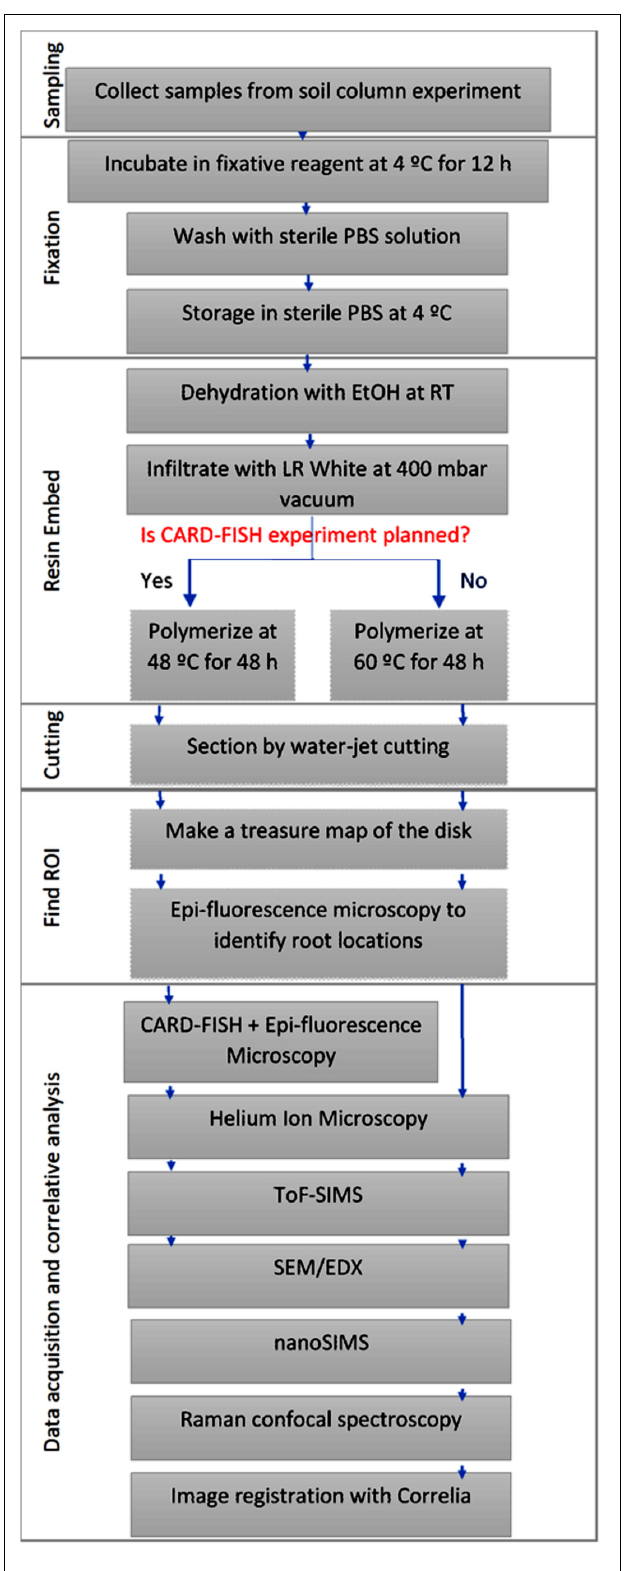
FIGURE 1 | Schematic representation of the sample preparation, image registration and correlative